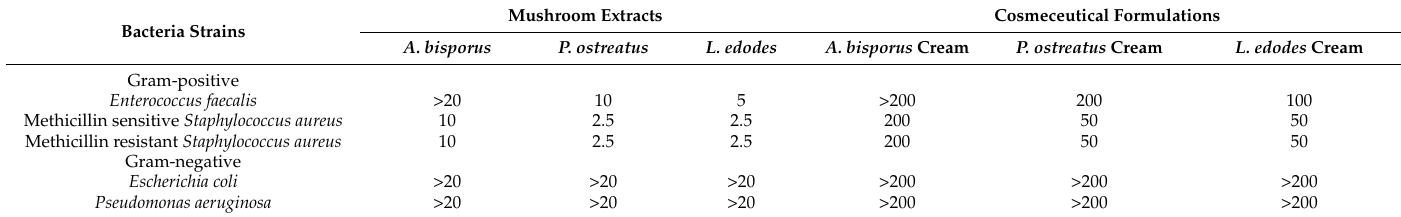
Table 3. Antibacterial activity of the mushroom ethanolic extracts and of the cosmeceutical formulations (MIC values, mg/mL). Bacteria Strains